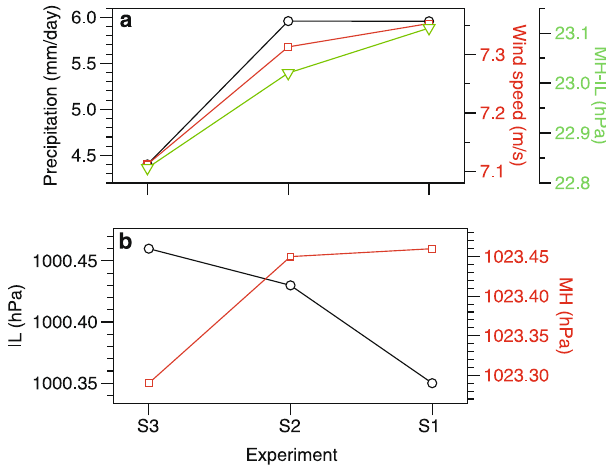
Fig. 5 | Variations in model-exported parameters. a Simulated 850-hPa wind speed (m/s) and precipitation (mm/day) averaged for the summer season (June, JulyandAugust;JJA)inthearea(50° – 75°E,5°S – 20°N),pressuregradient(MH-IL)of the Mascarene High (MH; 40° – 90°E, 25° – 35°S) relative to the Indian Low (IL; 40° – 80°E, 20° – 30°N) under three scenarios with growth of the Antarctic and Greenland ice-sheet. b Variations in MH and IL under three scenarios. Scenarios of S1andS2representtheicecoveraccumulated inthe EastAntarcticaand thewhole Antarctica, respectively. Scenario S3 represents the pre-industrial ice cover in Greenland superimposed on a constant ice-sheet cover in the whole